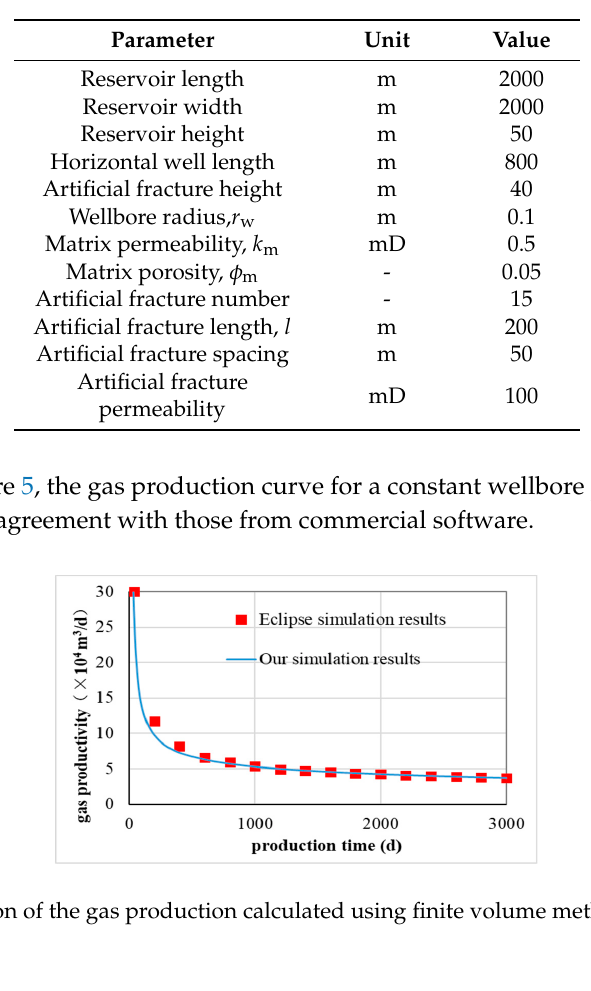
Table 3. The parameter set for the shale gas reservoir model.